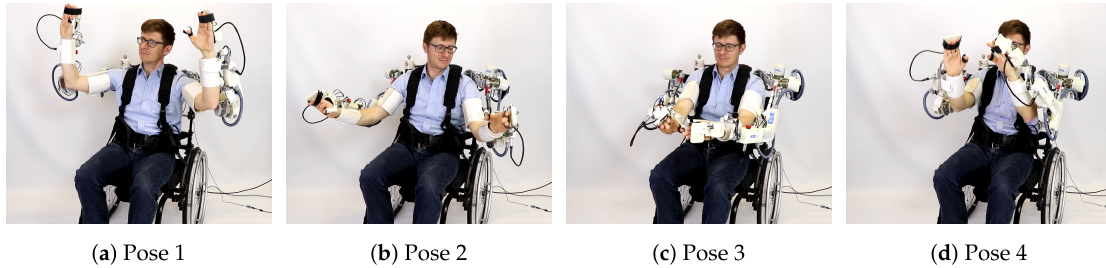
Figure 18. Master slave mode with human